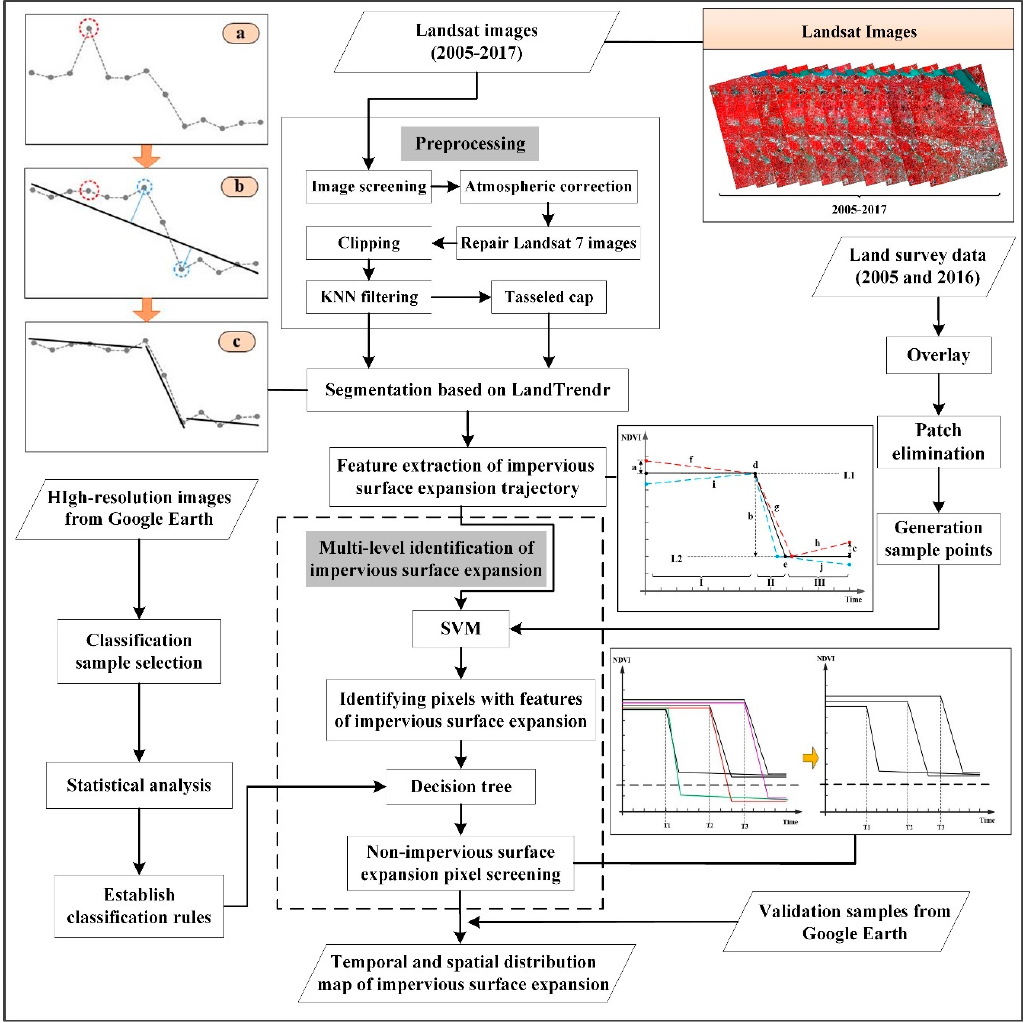
Figure 2. The flowchart of impervious surface expansion monitoring. KNN, k-nearest neighbor; SVM, support vector machine.